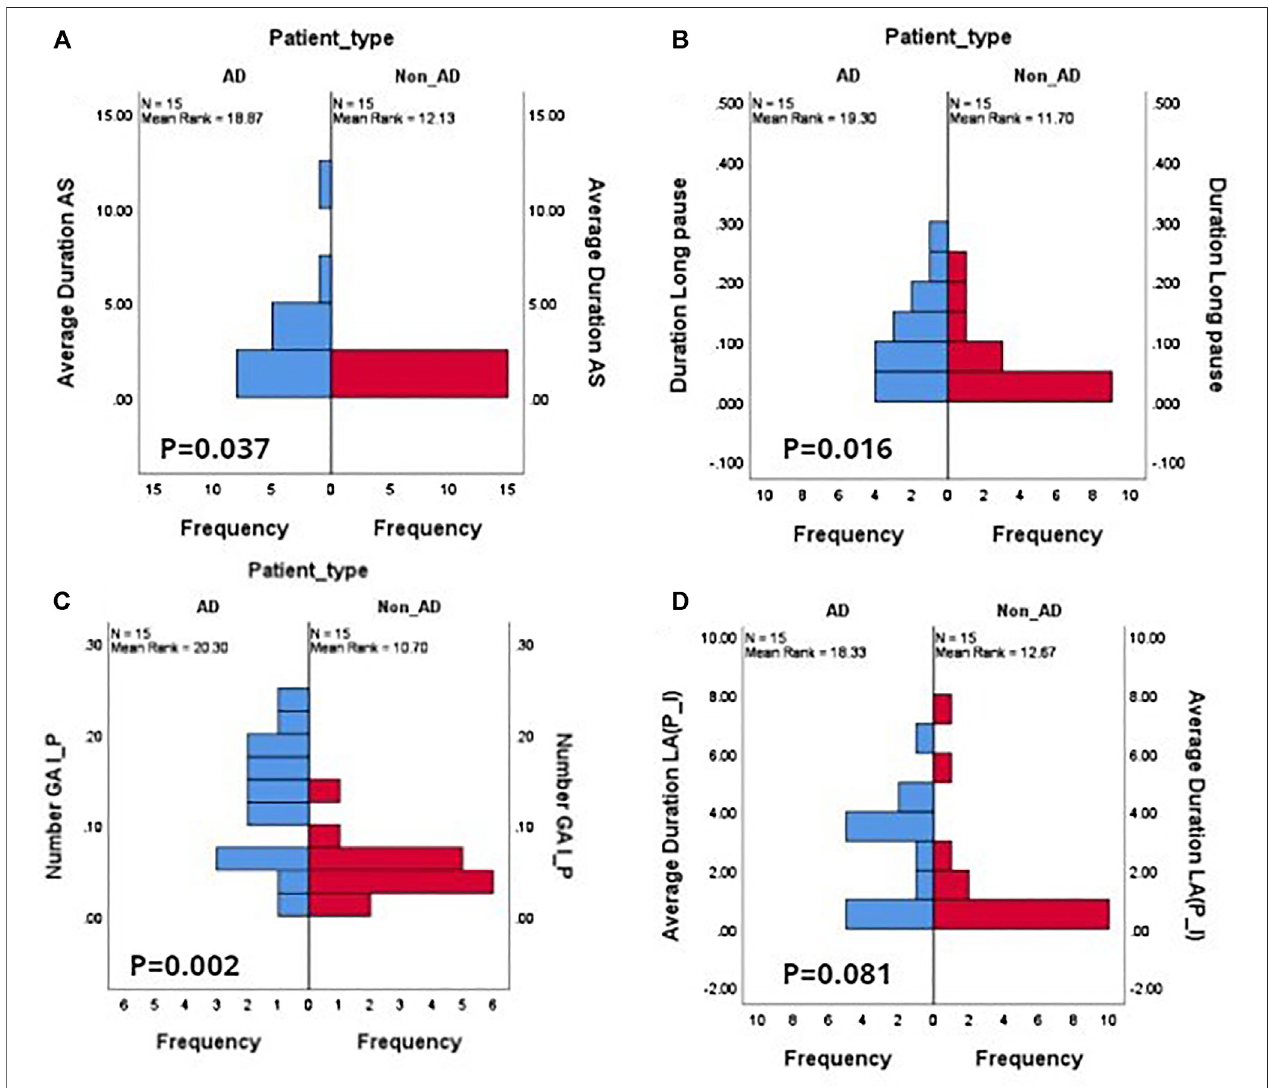
FIGURE 1 | Feature value histograms for a selection of different pause types, showing differences in distributions between AD and non-AD dialogues. (A) Average duration of patient attributable silences AS ; (B) duration of patient long pauses LP ; (C) frequency distribution of interviewer-to-patient gaps GA(I – P) ; (D) duration of patient-to-interviewer lapses LA(P – I) . (A) , (B) , (C) show distributions that are signi fi cant at p < 0 . 05, while for (D) 0 . 05 < p < 0 .